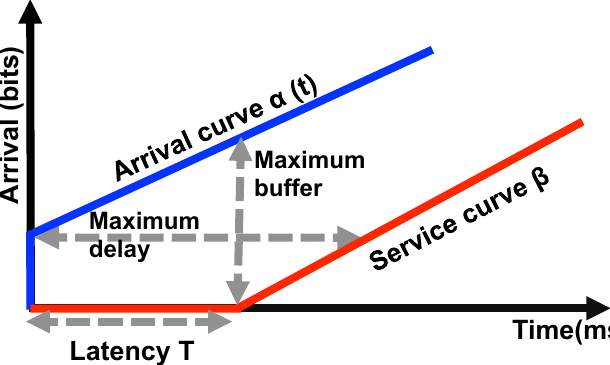
Figure 5. Network calculus—( b , r )